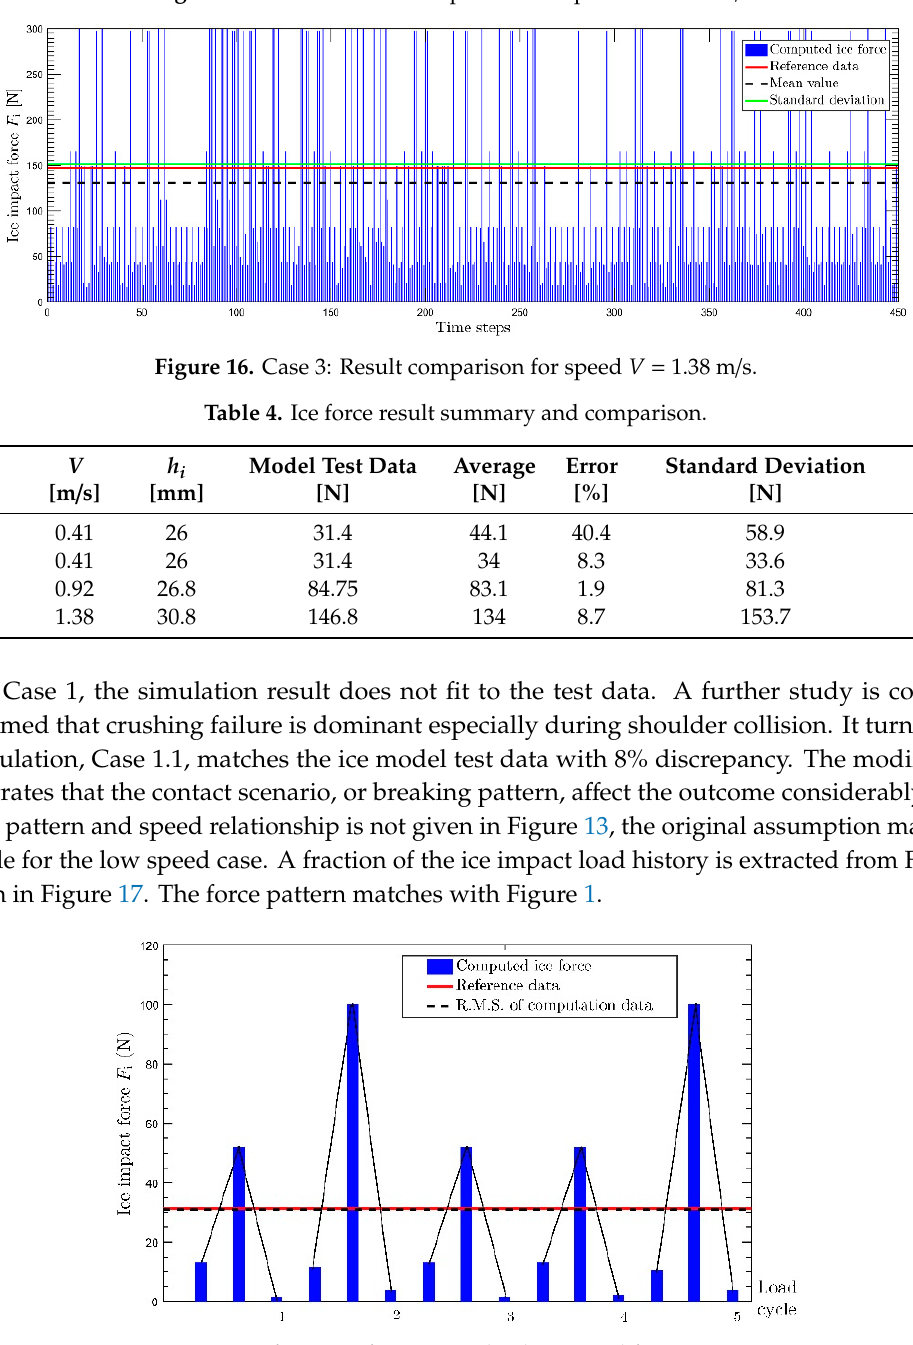
Table 5. Ice breaking length result summary and comparison (unit: m). Bow